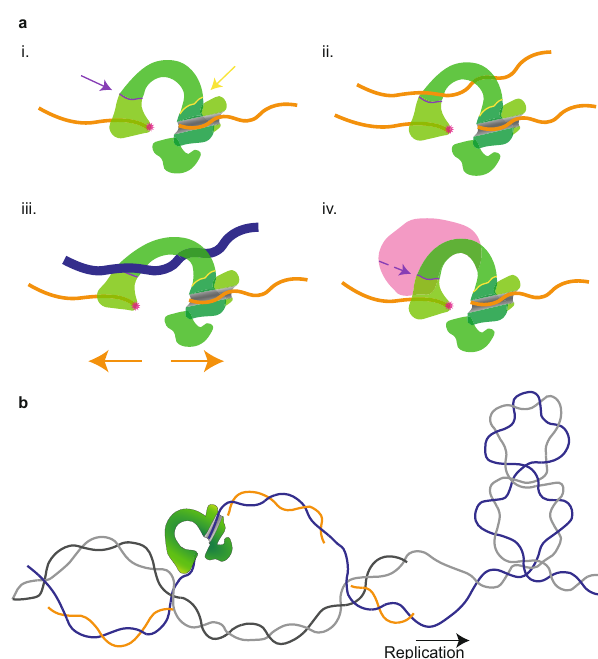
Fig. 7 Schematic representation of TRR-ssDNA gate plasticity and its potential relevance in vivo. a Effects of co-factors on TRR-ssDNA gate mechanics. i Upon binding to ssDNA (orange), TRR (green) pivots to create an open gate in the TRR-ssDNA complex. The purple line and arrow highlight the location of a primary hinge in the enzyme that facilitates gate opening. An additional potential hinge is indicated by the yellow line and arrow. ii Binding of ssT-DNA (second orange strand) to the open TRR- ssDNA gate does not in fl uence the gate size. iii Binding of dsT-DNA (blue) to the open TRR-ssDNA gate induces an increase of the gate size by at least ~16%. iv Proposed interaction of BLM (pink) with TRR in the BTRR complex. BLM is hypothesized to alter the overall fl exibility of the gate by making contact near the primary hinge (purple line and arrow) of the topoisomerase. b Schematic representation of potential in vivo activity of TRR on pre-catenanes behind the replication fork (arrow indicates the direction of replication). TRR (green) may bind to ssDNA on the lagging strand template (blue), between Okasaki fragments (orange), and mediate transfer of the leading strand dsDNA